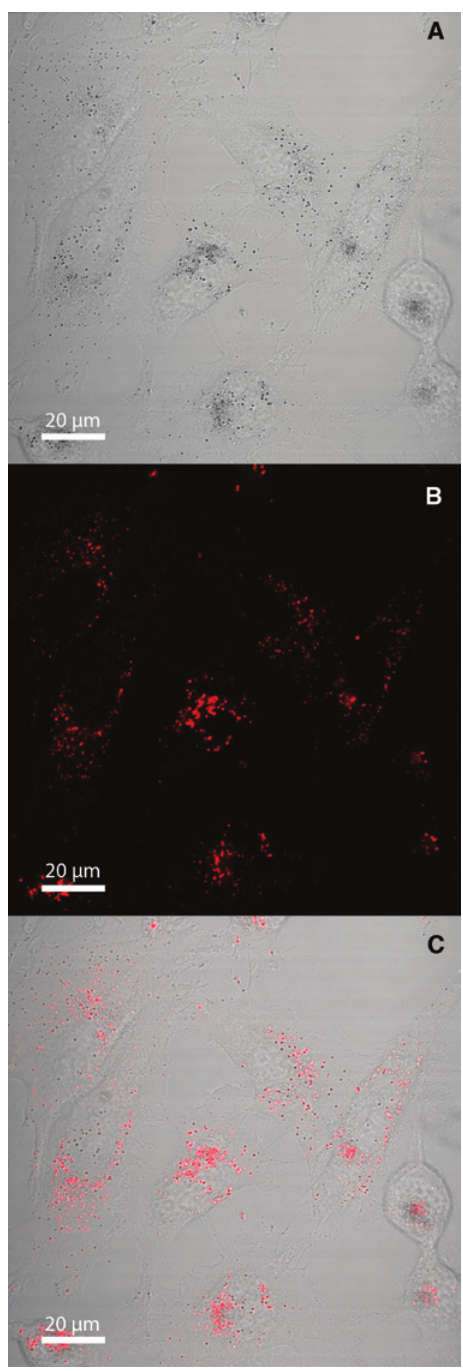
Figure 10: Confocal microscopy images of HeLa cells incubated with YVO :Eu 3 + , Bi 3 + NPs for 24 h. 4 (A) Transmission channel, (B) fluorescence channel ( λ